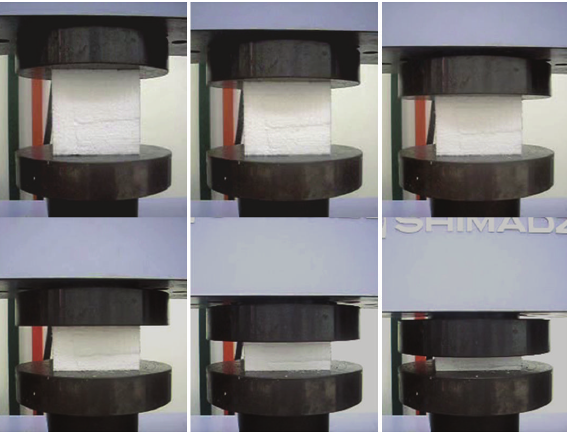
Figure 1: Quasistatic compression test of EPS crushable foam.